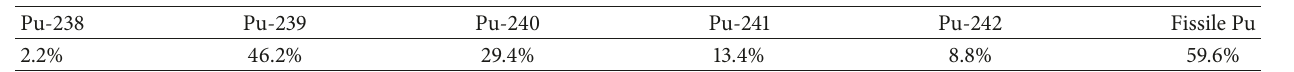
Figure 1: A modern 10 × 10 BWR fuel assembly design. Table 1: Plutonium isotopic